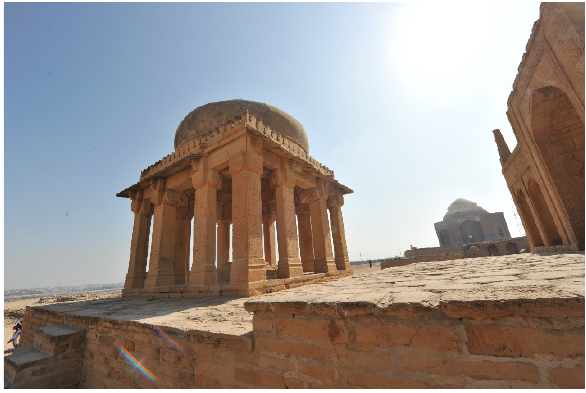
Figure 10. A canopy tomb near the southern extreme of the